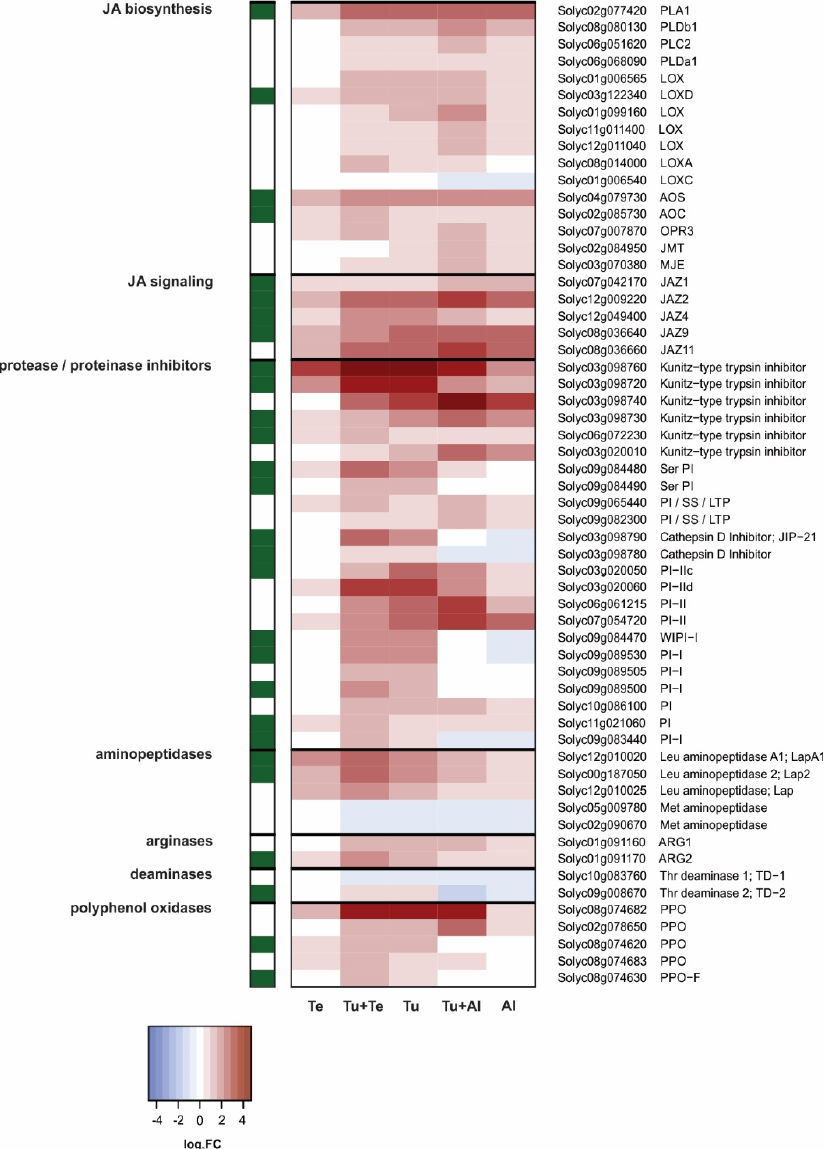
Figure 3. Gene-expression heat map depicting the relative transcript levels of tomato ( Solanum lycopersicum ) genes that encode proteins with a (predicted) function in the jasmonic acid (JA) pathway and that were differentially expressed in leaves after seven days of infestation with herbivorous mites. Tomato leaves were infested with either a single mite species ( Tetranychus urticae (Tu), Tetranychus evansi (Te), or Aculops lycopersici (Al)) or two species simultaneously ( T. urticae plus T. evansi (Tu+Te), or T. urticae plus A. lycopersici (Tu+Al). Non-infested plants served as controls and were used as a common reference in the transcriptional comparisons. Presented genes were differentially expressed (Benjamini and Hochberg false discovery rate adjusted p ≤ 0.05; Log 2 fold change (FC) ≥ 0.585) in at least one of the mite-infestation treatments. The different (sub)sections of the pathway are specified on the left. Dark green squares in the leftmost column denote that transcription of the respective gene was found to be significantly induced in the tomato JA-biosynthesis mutant def-1 , 24 h after exogenous application of JA (for details see [39]).